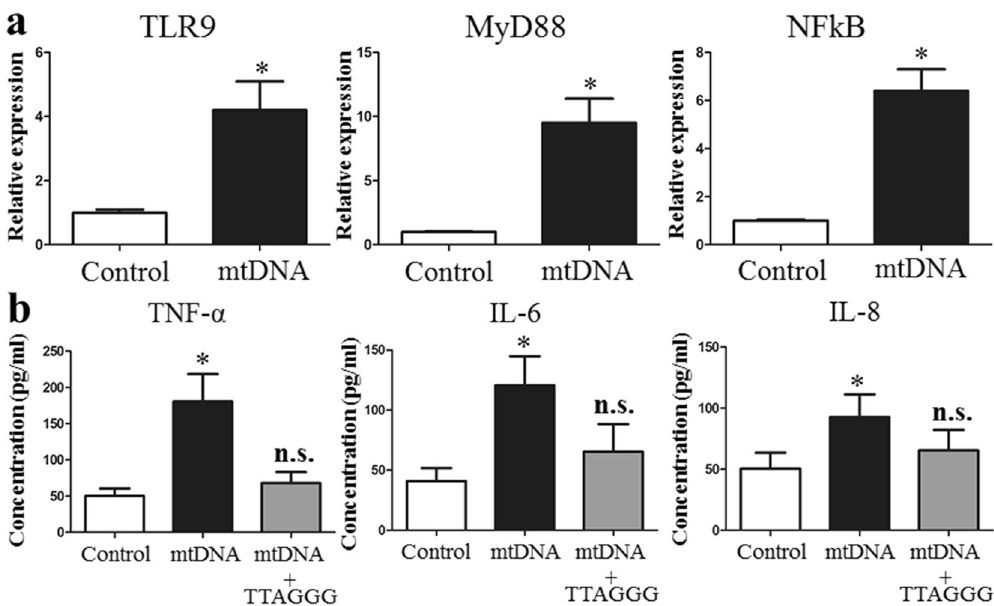
Figure 8. mtDNA induces pDC cell lines to up-regulate TLR9 expression and induced the inflammatory response. ( a ) The expression levels of TLR9, MyD88, and NF- κ B was significantly increased with mtDNA co-culture compared with those in the control. ( b ) Freshly isolated primary human pDCs were treated with oxidatively modified mtDNA in the absence or presence of a TLR9 antagonist (TTAGGG). The data are expressed as means ± SD. * P < 0.05 vs the sham group or H/R